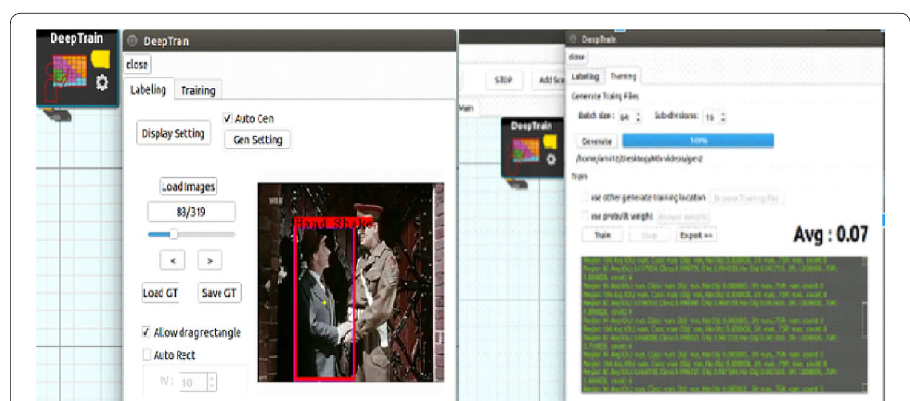
Fig. 4 Demonstration of DeepTrain module on image frames on AVA